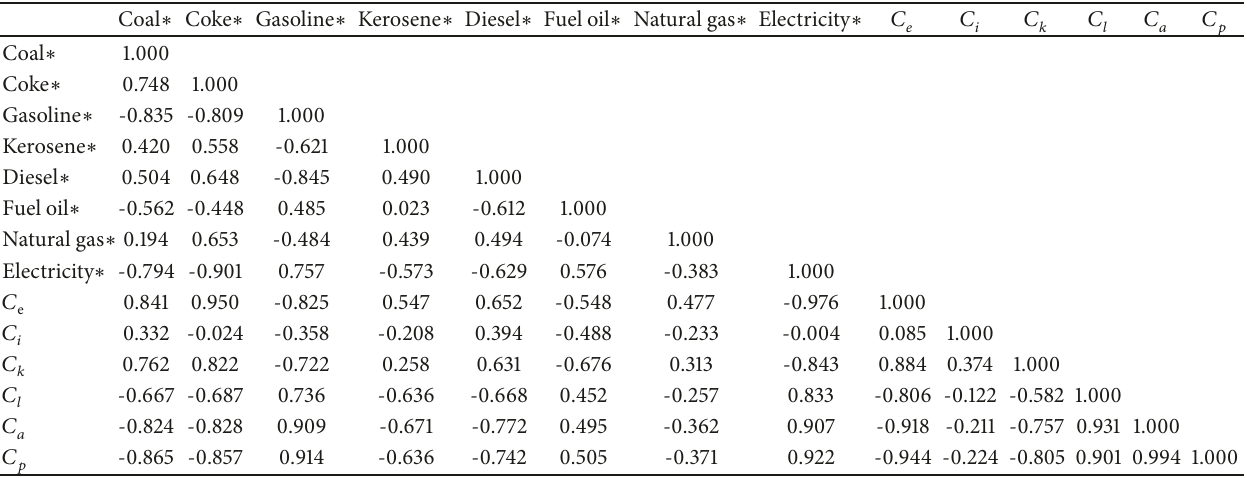
Table 4: The correlation coefficient matrix between 14 influencing factors.